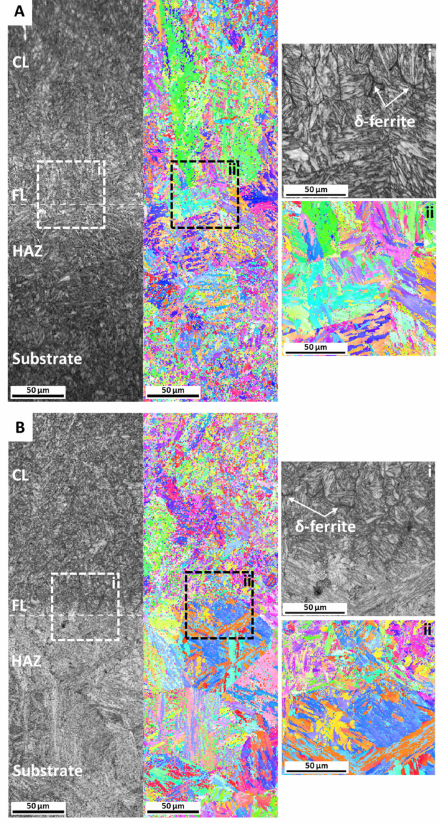
Figure 5. Electron backscatter diffraction (EBSD) images showing the microstructure of M2_6_15 samples ( A ) with and ( B ) without PHT.